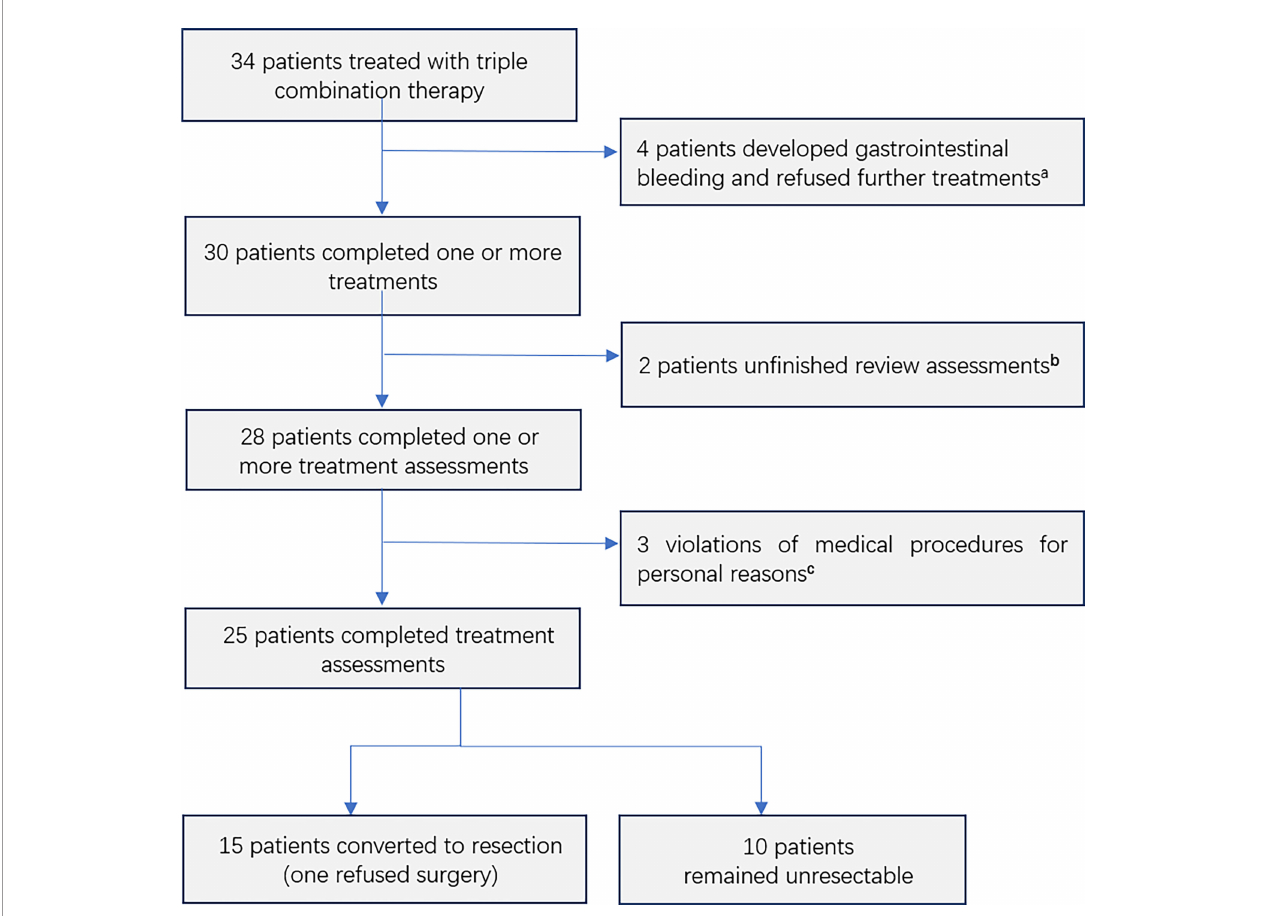
FIGURE 1 | Consolidated Standards of Reporting Trials diagram including all 34 patients who entered into the study. a All four patients had gastric fundus varices owing to portal hypertension. Two patients had grade 3 gastrointestinal bleeding, which was treated endoscopically. Two patients had grade 1 gastrointestinal bleeding, which was not treated. b Two patients did not follow the procedure requiring a review of imaging 4 – 8 weeks after the last HAIC treatment. c The interval between the two HAIC treatments was >8 weeks for personal